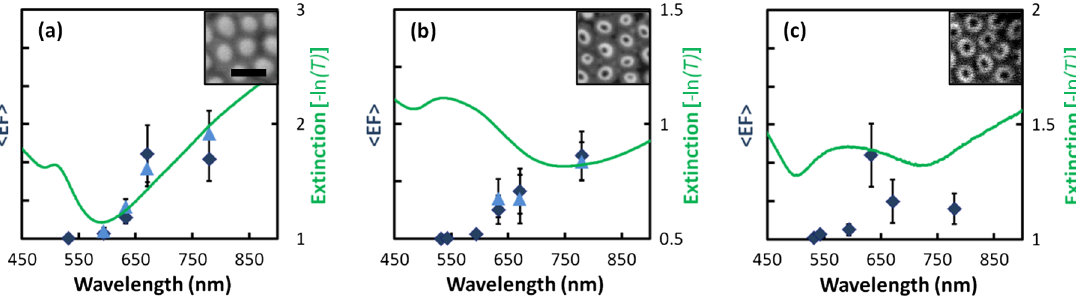
FIG. 7. Graphs comparing the measured enhancement factor h EF i and optical extinction [ (cid:1) ln ð T Þ ] at normal incidence for (a) nanorods with an average diameter of 48 nm and for (b),(c) nanotubes with average wall thickness and diameter, respectively, of 12 and 45 nm and of 9 and 50 nm. In all three cases, the average array period was 65 nm and nanorod or tube length was approximately 100 nm. The green curves indicate the optical extinction of the samples. Black-diamond and blue-triangle data points indicate the h EF i of the 915 - cm (cid:1) 1 band of CV and the 775 - cm (cid:1) 1 band of R6G, respectively. Inset: SEM images of each sample. All SEM images are on the same scale (scale bar ¼ 100 nm ).